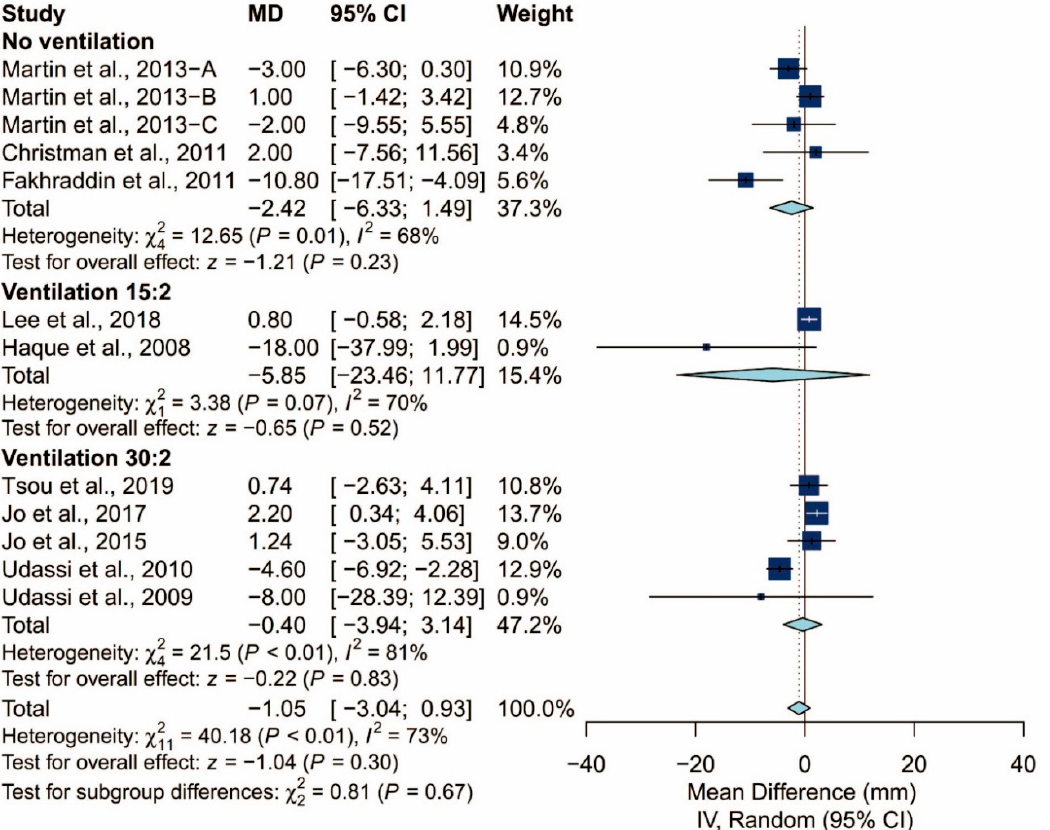
Figure 8. Subgroup analysis of chest compression rate grouped by ventilation protocol (15:2/30:2/no).